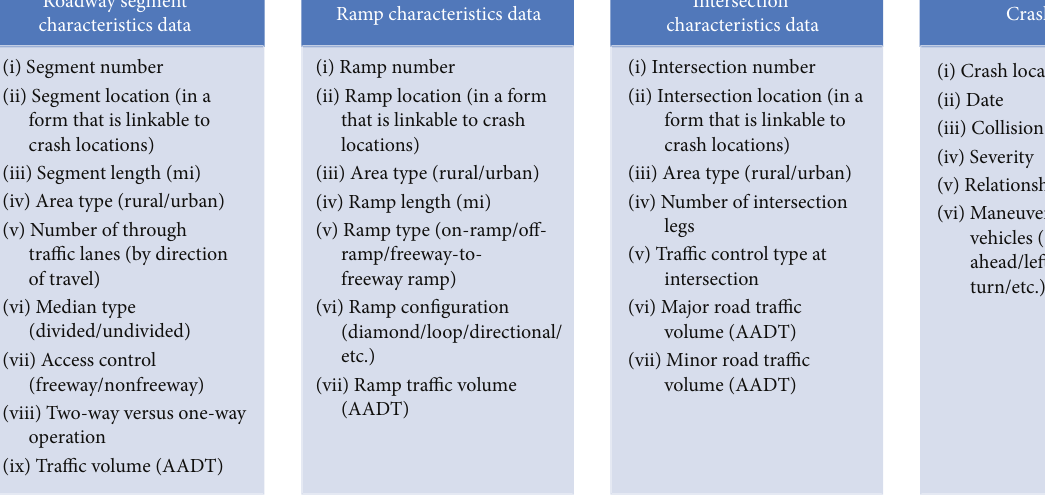
Figure 2: Mandatory data elements required by Safety